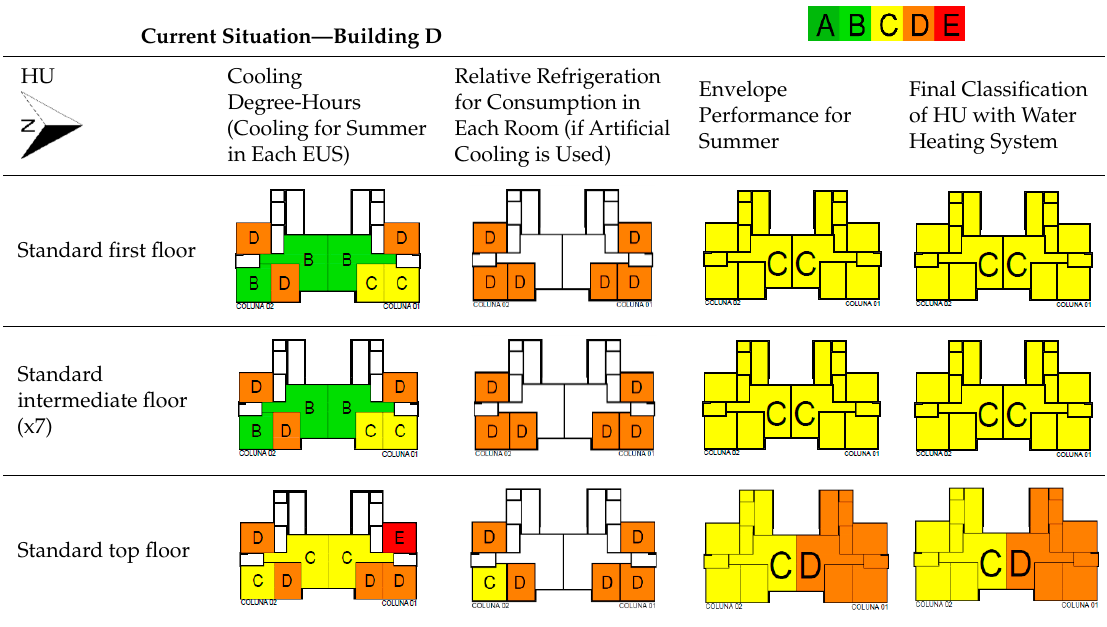
Table 4. Comparison of the conformity of representative buildings with the quality technical